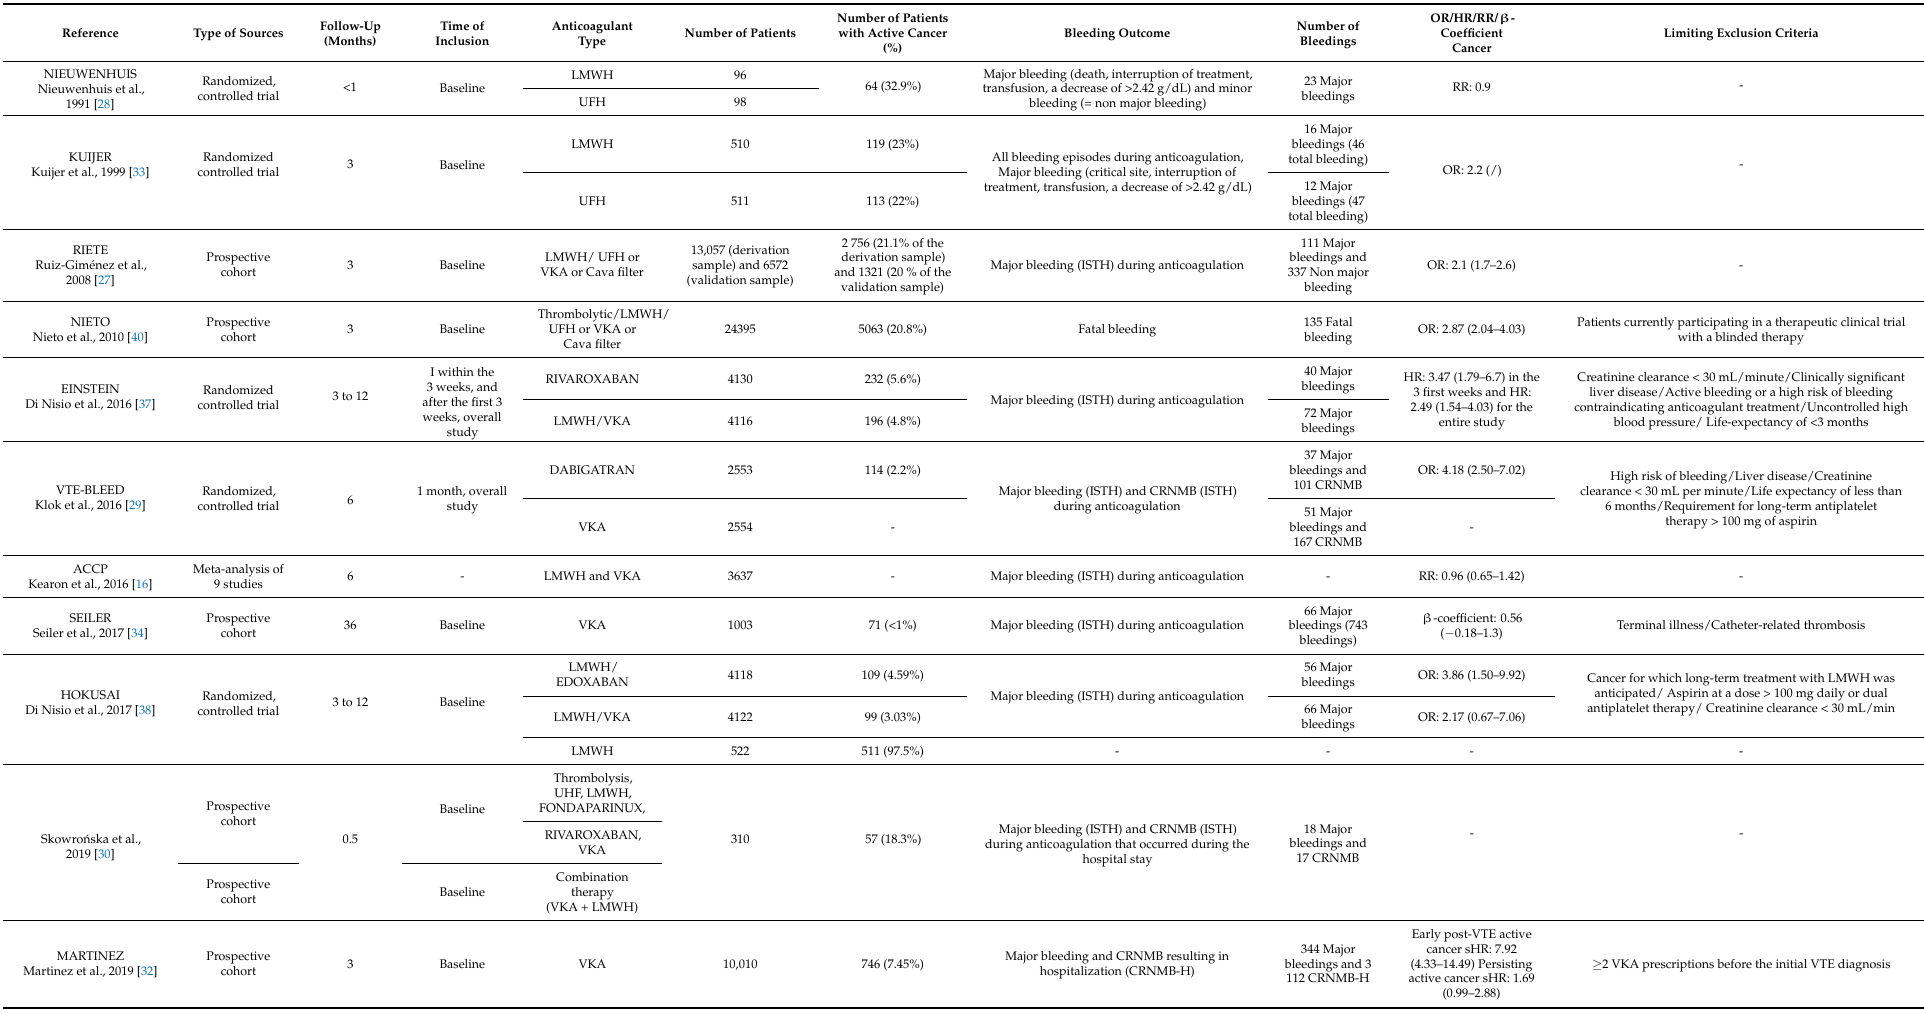
Table 4. Risk assessment model developed to assess bleeding